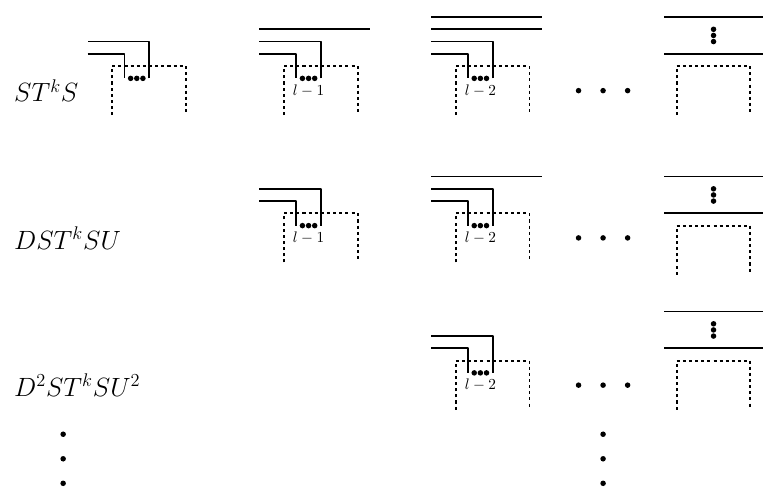
Figure 9. A schematic drawing of the di(cid:11)erent contributions to the transition matrix. Each diagram in the (cid:12)gure stands for the sum of the diagrams with the indicated number of chords closing in the M -region. The i ’th row stands for the correcting diagrams with l (cid:0) i + 1 chords entering the M -region (and then i additional chords are added). In the j ’th column, we see all the diagrams where l (cid:0) j + 1 chords close in the M -region.